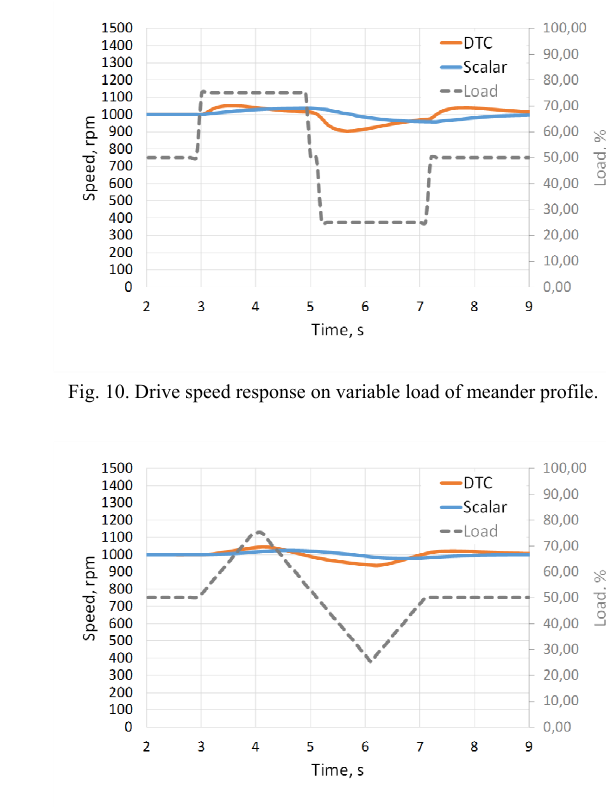
Fig. 11. Drive speed response on variable load of triangle profile.